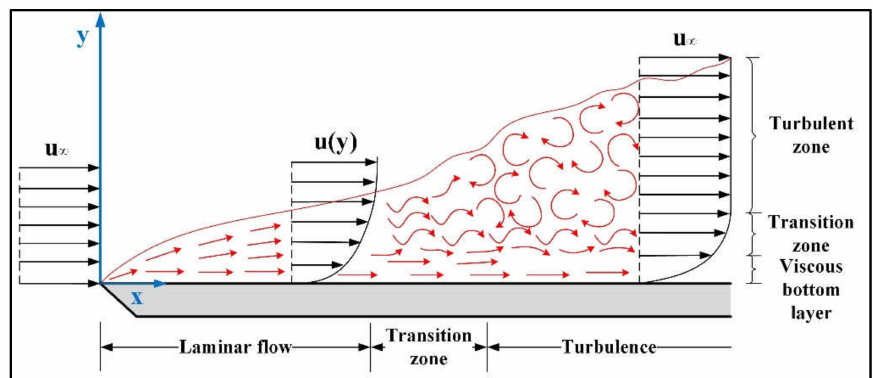
Figure 3. Diagram of Variation of Velocity Boundary Layer on Plate.